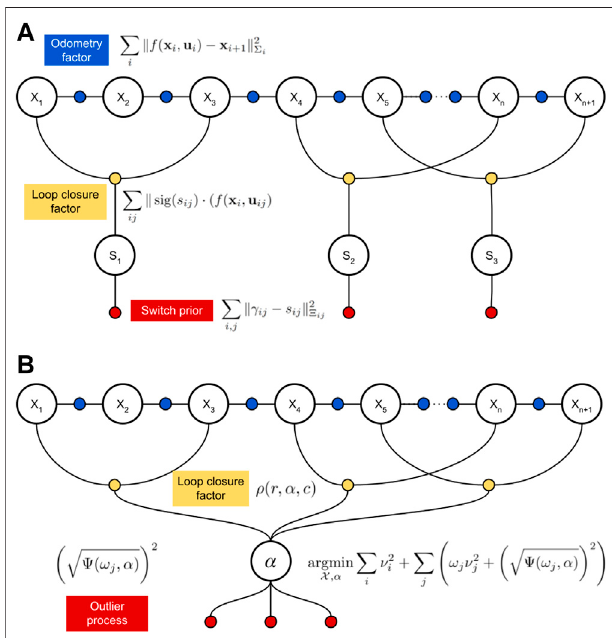
FIGURE 1 | Representation of loop closing factors and their additional components added to the graph by the SC method (A) and our proposal (B) . As seen, in the SC structure, each switchable loop-closure is accompanied with a switch variable (s i ) and a prior constraint (P i ). In contrast, in the structure of AEROS, all the adaptive loop closures are connected to the latent parameter ( α ) and for every loop closure constraint an outlier process is de fi